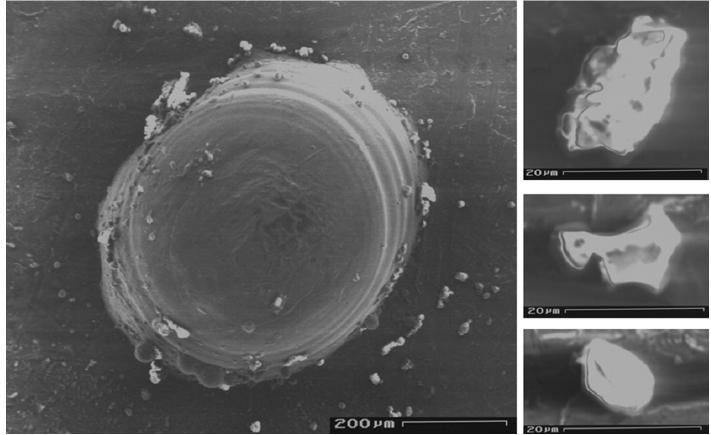
Figure 3. Optical microscopy images of particles found in the vicinity of the weld: left side-round droplet that was probably still liquid when it hit the surface. The impact produced a splash of molten metal around it; right side-particles of irregular shape.